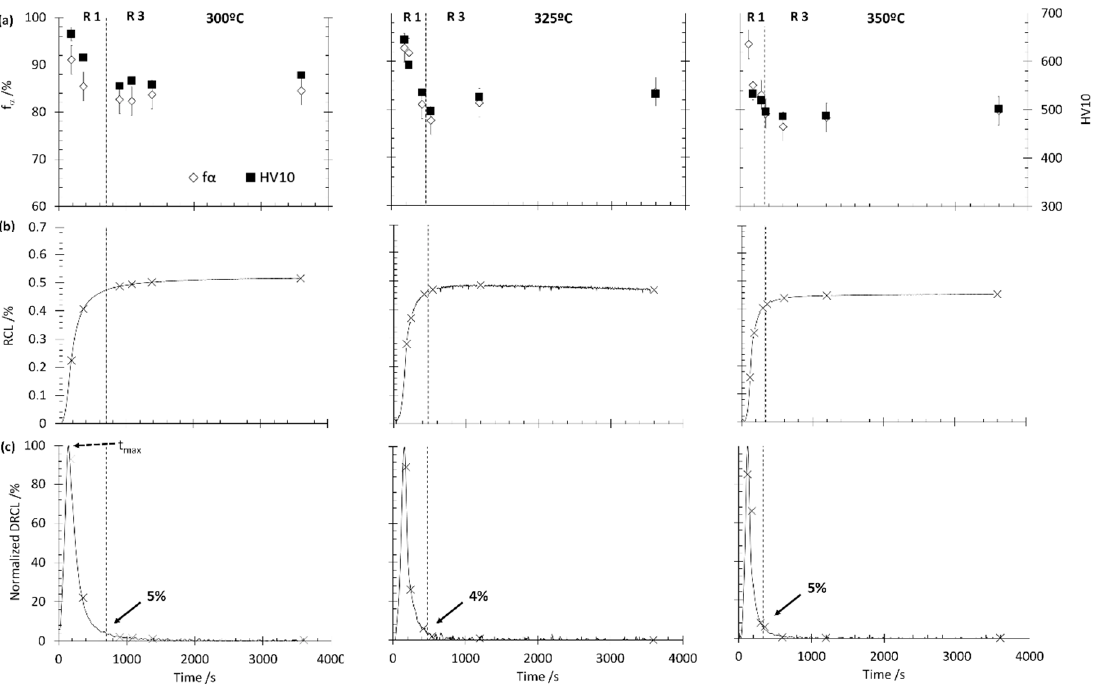
Figure 2. For Steel 1 treated at di ff erent isothermal temperatures and times, ( a ) experimental fraction of ferrite (f α ) and Vickers hardness measurements (HV) as a function of time, ( b ) the relative change in length (RCL) from the dilatometry test, and ( c ) normalized derivative of the relative change in length (DRCL). The x symbols in ( b , c ) indicate the position of the interrupted tests whose f α and HV are also indicated in (a). Vertical dotted lines denote the limits of regions (R1 and R3) as described in the main body of the text and schematically shown in Figure 1. Note that region R2 is not detectable for Steel 1.